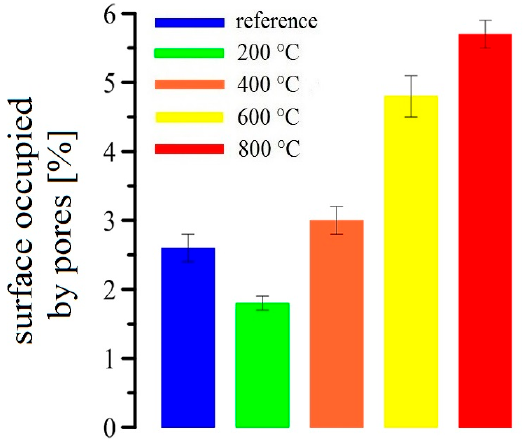
Figure 14. Results of image analyses of UHPC specimens after their exposure to elevated temperatures.